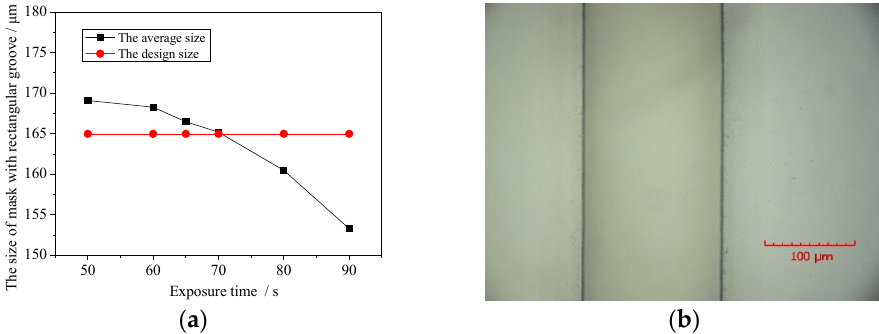
Figure 5. Exposure results: ( a ) average mask size relative to design size with different exposure times; ( b ) local morphology of mask with exposure time of 70 s. Table 4. Settings for baking after